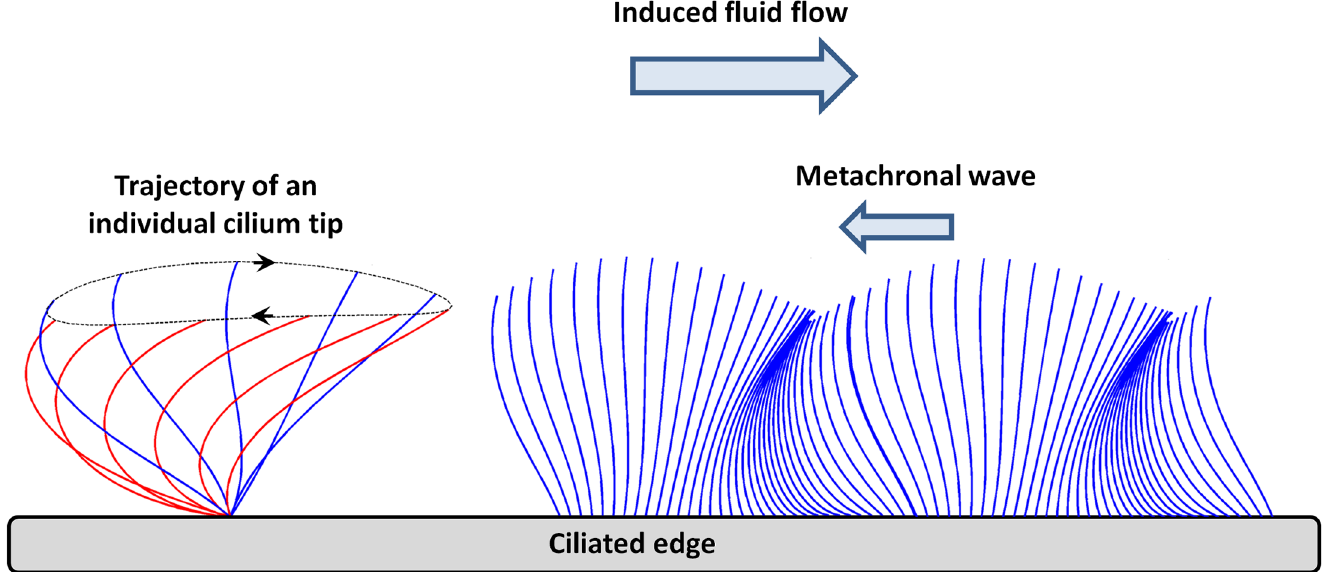
Fig 1. Schematic representation of the stroke of an individual cilium and the envelope model. (Left) Simplification of the stroke cycle as an ellipse. (Right) Representation of the envelope model coveringthe cilia layer and the propagationof the metachronal wave. (Inspired by Velez-Cordero et al. [23])